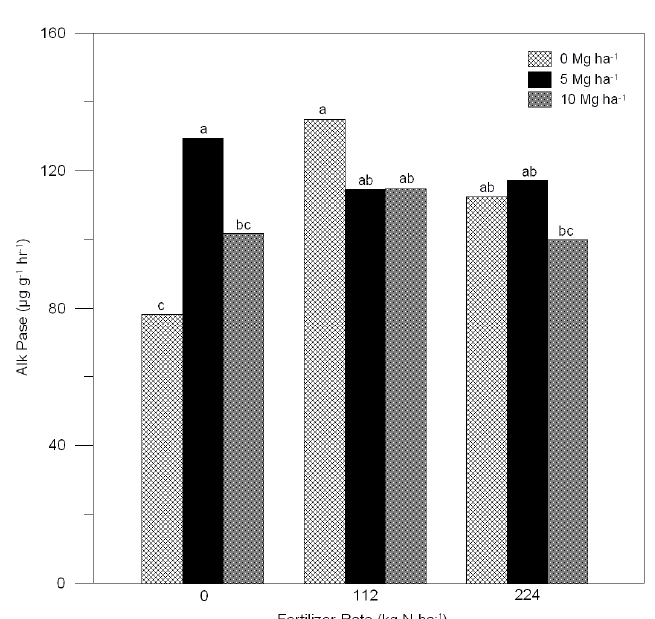
Figure 1. Alkaline phosphatase (Alk Pase) enzyme activity as influenced by pine woodchip biochar and fertilizer rates. The fertilizer rates are 0, 112, and 224 kg·nitrogen (N)·ha − 1 rates. The biochar treatments are displayed in the shaded boxes at rates of 0, 5, and 10 Mg·ha − 1 . Bars with different letters are statistically different from each other ( p <